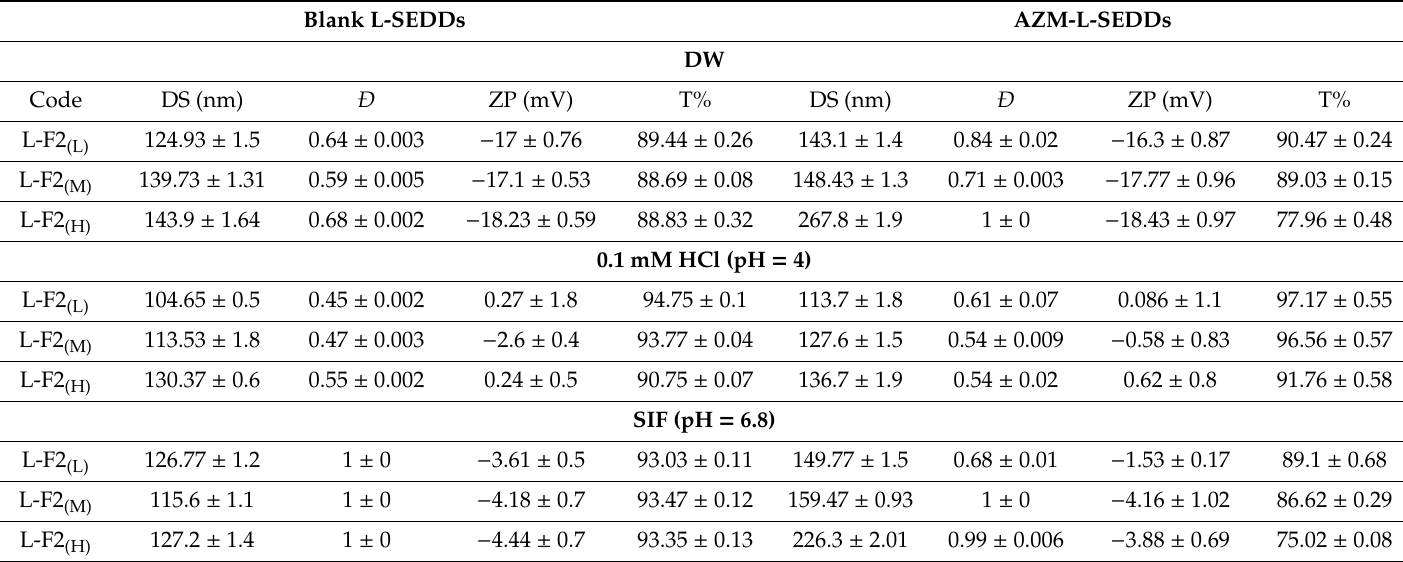
Table 5. Characterization of blank and AZM-L-F2 formulations at Octanoic acid oil concentrations of low, medium, and high analyzed in the three diluents. Mean ± SD, n =